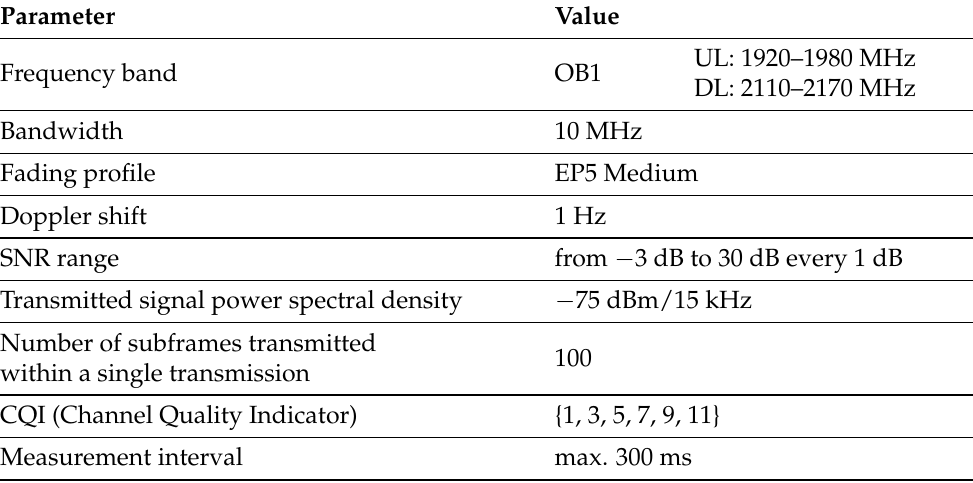
Table 1. Emulated base station operating parameters for the MC1 measurement